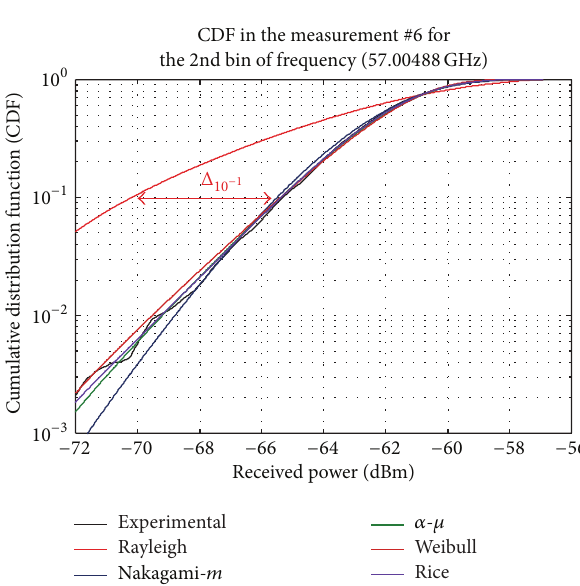
Figure 5: Probability density functions of the fading parameter in logarithmic units, 10 log 𝑚 , and the Gaussian approximation for the measurements #2 and #5.